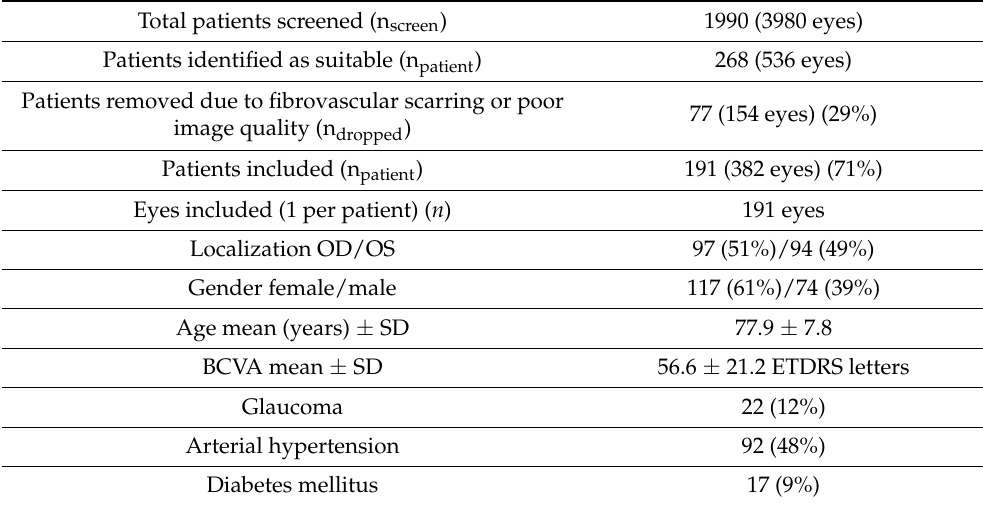
Table 1. Demographic data. Total patients screened (n screen